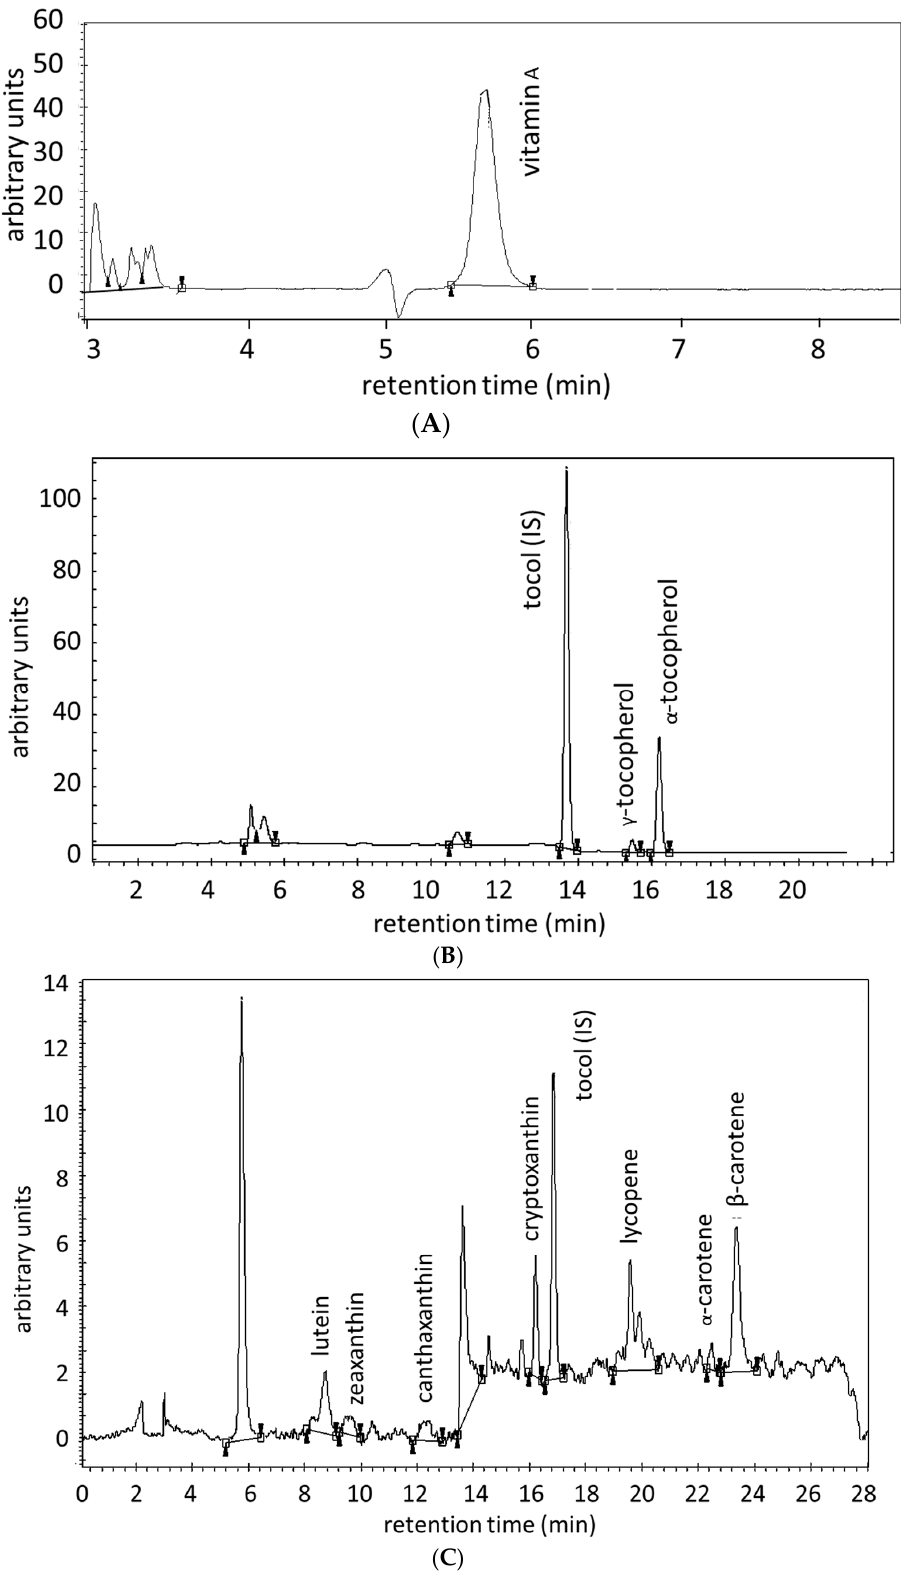
Figure 3. Chromatogram of the separation and detection of vitamin A ( A ); α - and γ - tocopherol ( B ); and seven carotenoids ( C ) in the same HPLC procedure. These HPLC chromatograms are from the study described in reference 13 [13].